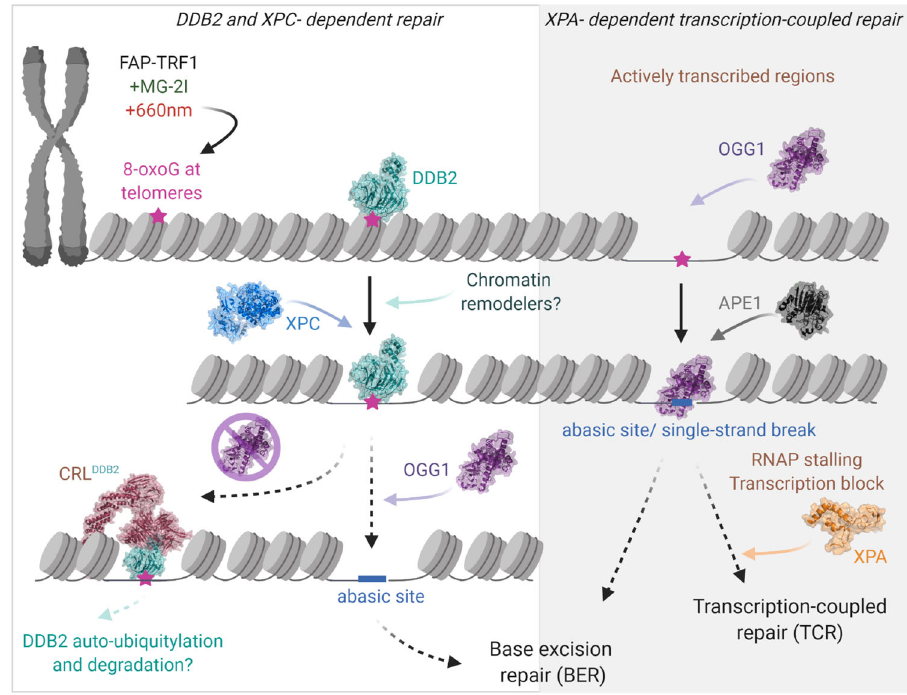
Fig. 7 Uni fi ed working model: role of NER proteins in 8-oxoguanine repair. Treatment of cells expressing FAP-TRF1 with dye (100 nM, 15 min) plus light (660 nm, 10 min) introduces 8-oxoG lesions at telomeres. In the DDB2-dependent repair pathway, DDB2 recognizes 8-oxoG lesions and facilitates chromatin relaxation through chromatin decompaction allowing the recruitment of XPC and OGG1 to the damage site. OGG1 recruitment facilitates the dissociation of DDB2. In the absence of downstream repair, DDB2 is retained longer at 8-oxoG sites requiring DDB1-Cul4A-RBX1 (CRL) mediated DDB2 dissociation. At actively transcribed regions, OGG1 can access the lesion independent of DDB2. 8-oxoG processing can lead to toxic BER intermediates that can act as a transcription block. Transcription-coupled repair (TCR) proteins, including XPA, participate in the repair of these BER intermediates. (See also Supplementary Movie